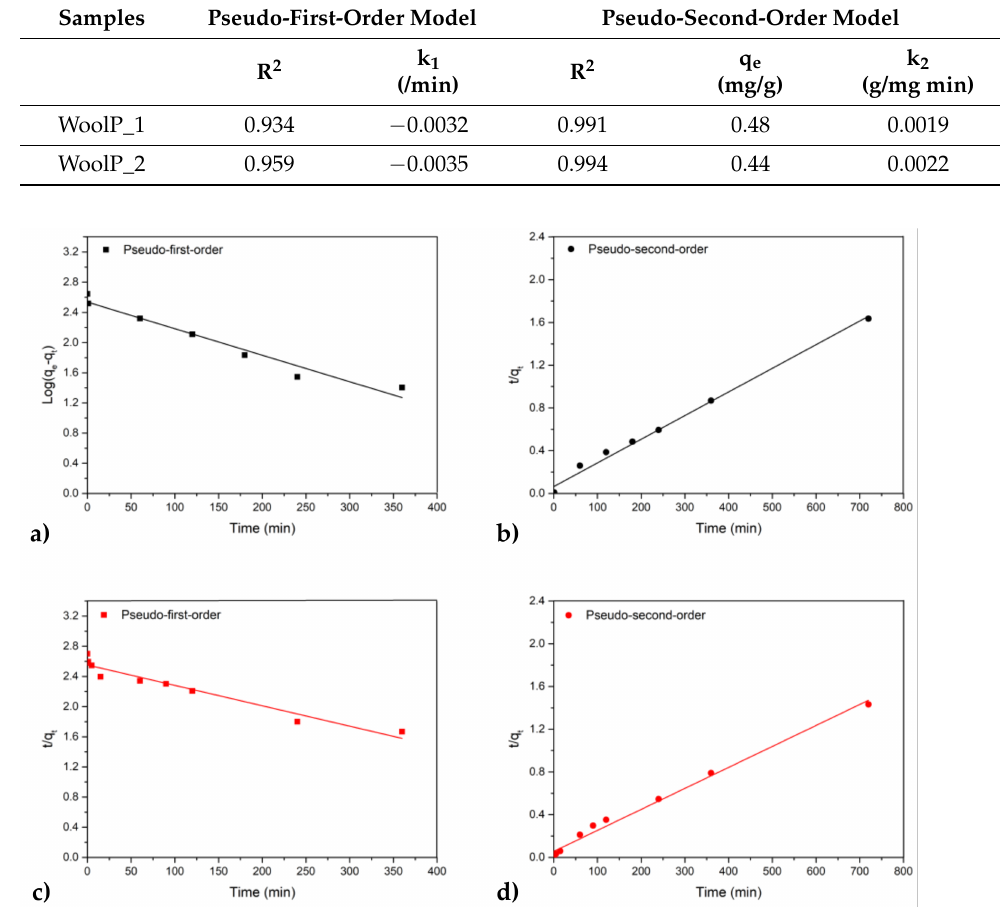
Figure 12. Kinetic parameters evaluated for the processes WoolP_1 ( a , b ) and WoolP_2 ( c , d ) using pseudo-first-order ( a , c ) and pseudo-second-order ( b , d )